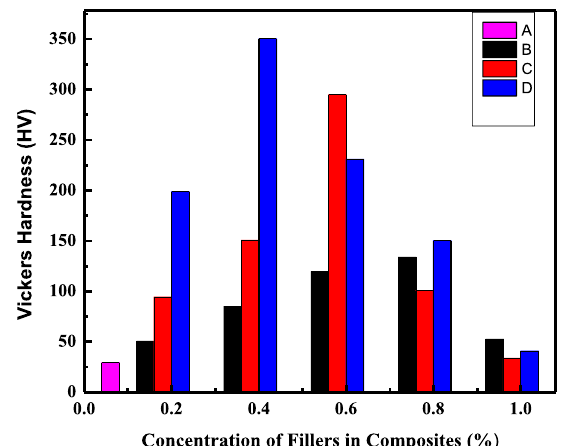
Fig. 12 Variation of Vicker ’ s hardness as a function of fi ller con- centration in the composites AR ( A ), C m C ( B ), WC ( C ), and CC ( D ) at 2 N load